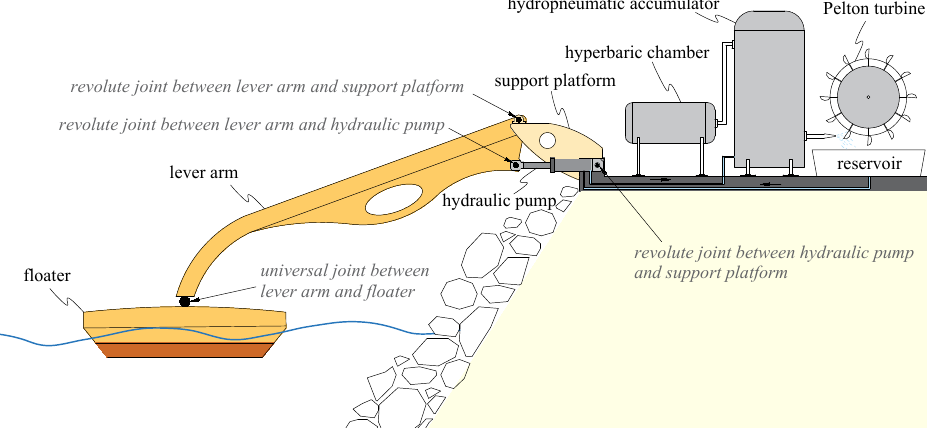
Figure 1. Schematic view of WEHC with main components (floater, lever arm, support platform and hydraulic PTO system), including the mechanical constraints among the three different sub-systems (universal joint between lever arm and floater, revolute joints between lever arm and support platform and hydraulic